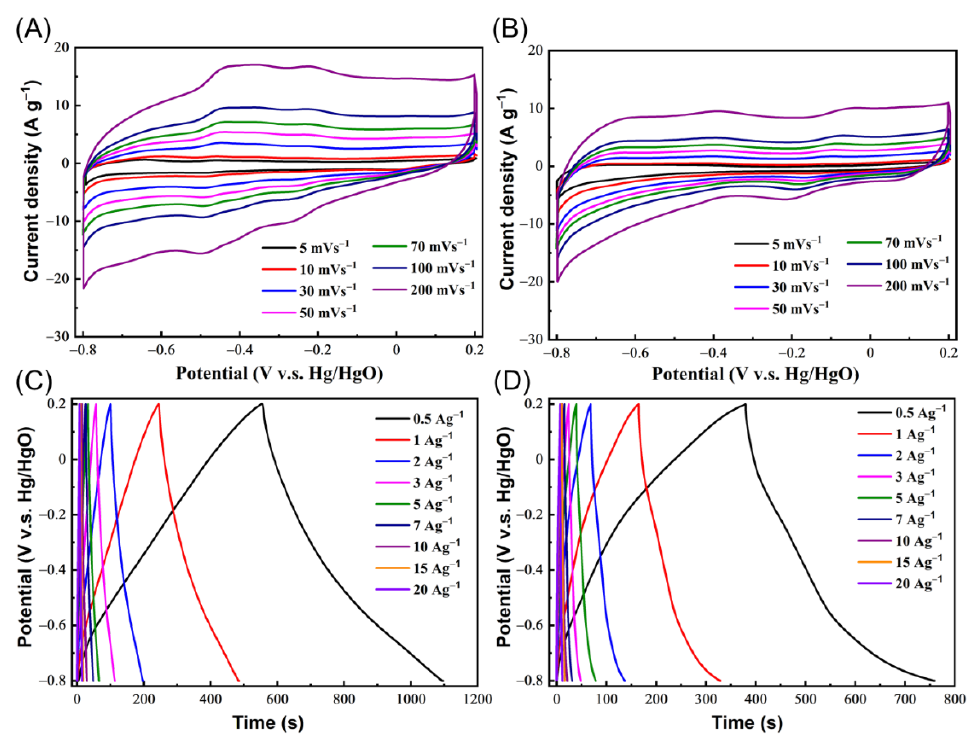
Figure 5. ( A , B ) CV curves of ( A ) TAPT-2,3-NA(OH) 2 and ( B ) TAPT-2,6-NA(OH) 2 COFs, measured at different scan rates (mV s – 1 ). ( C , D ) GCD curve of ( C ) TAPT-2,3-NA(OH) 2 and ( D ) TAPT-2,6-NA(OH) 2 COFs, measured at different current densities (A g − 1 ).